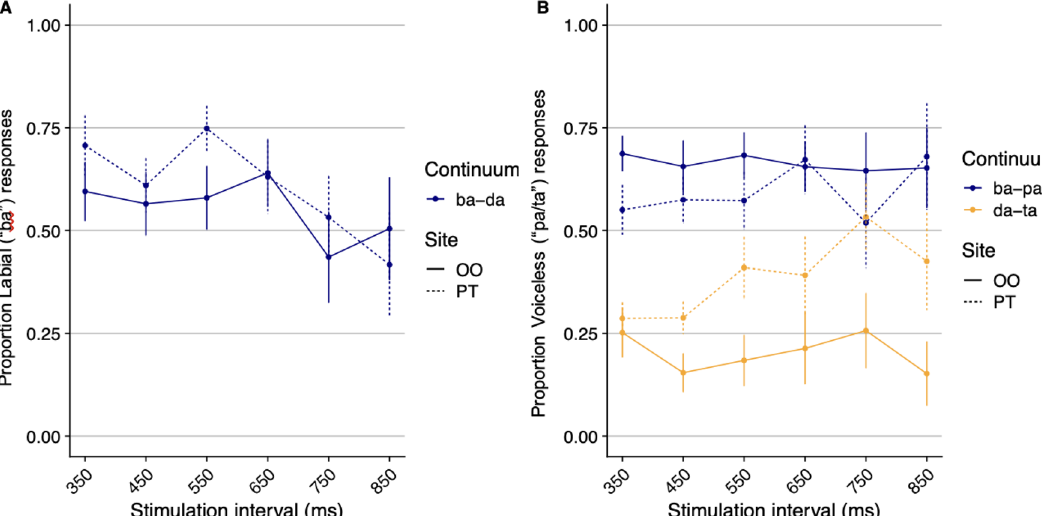
Figure 2. The effect of stimulation site (OO/PT) on the categorization of place of articulation (ba/da; A ) and voicing ( B ). In the ba-pa continuum; ba is the voiced response ( pa is voiceless); In the da-ta continuum; da is the voiced response (and ta is voiceless). Error bars are